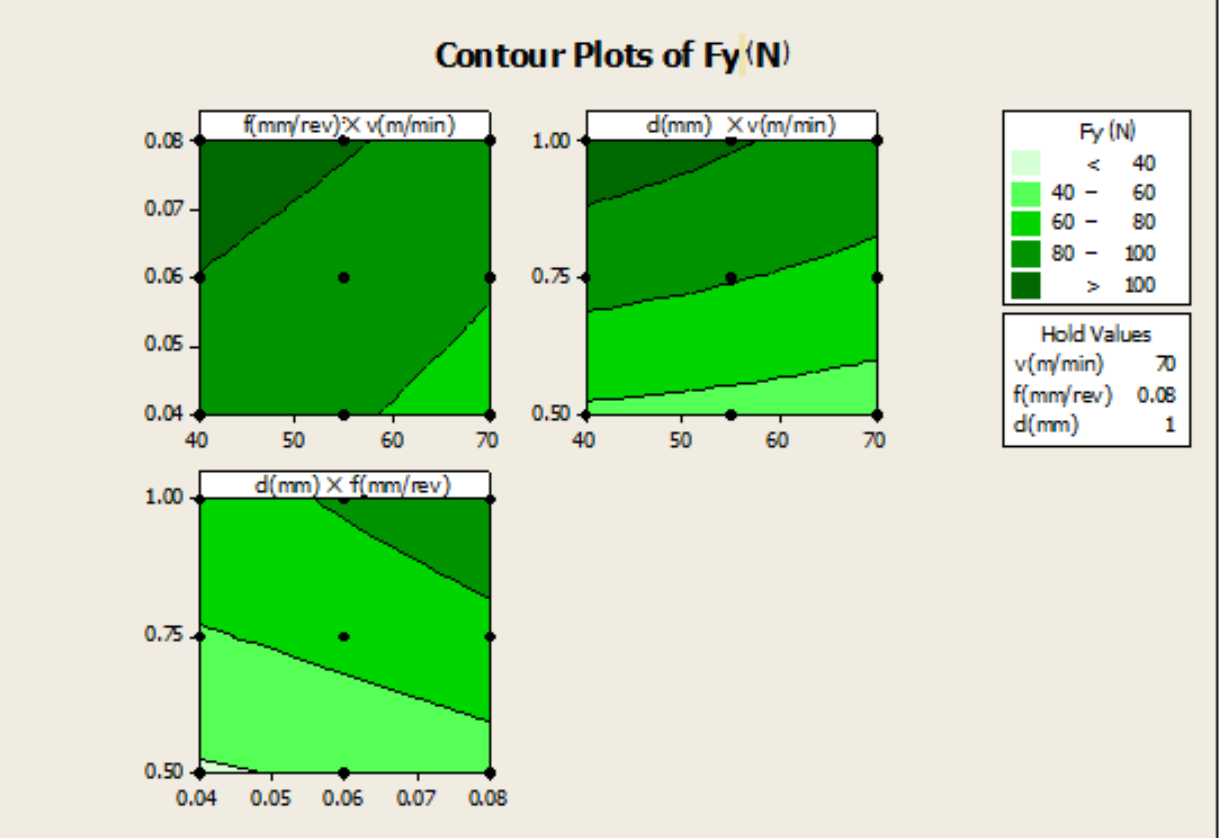
Figure 5. Contour plot for Fy. In Figure 6, ( f × v ) the plot indicates how variables such as feed rate and cutting speed are related to the Fz, while other factors such as depth of cut (d) are held constant, at a high value of 1. The response is at its highest (greater than 120) in the darkest region of the graph (the upper left-hand corner); ( d × v ) —this plot indicates how variables such as depth of cut and cutting speed are related to the F Z , while other factors such as feed rate are held constant, at a high value 0.08. The response is at its highest (greater than 120) in the darkest region of the graph (the upper left -hand corner); ( d × f ) —this plot indicates how variables, depth of cut and feed rate are related to the F Z , while other factors such as cutting speed are held constant at a high value of 70. The response is at its highest (greater than 120) in the dark region of the graph (the upper right-hand